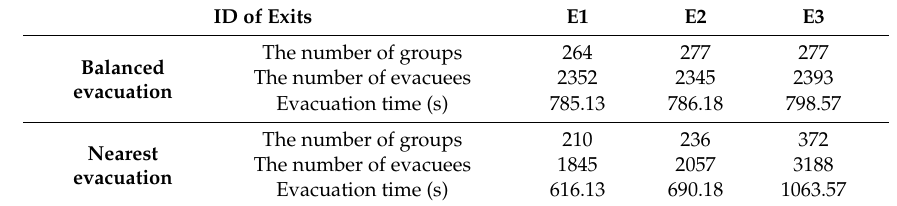
Table 2. The number of evacuees, the number of evacuation groups in different zones and their total evacuation time based on balanced evacuation and nearest evacuation